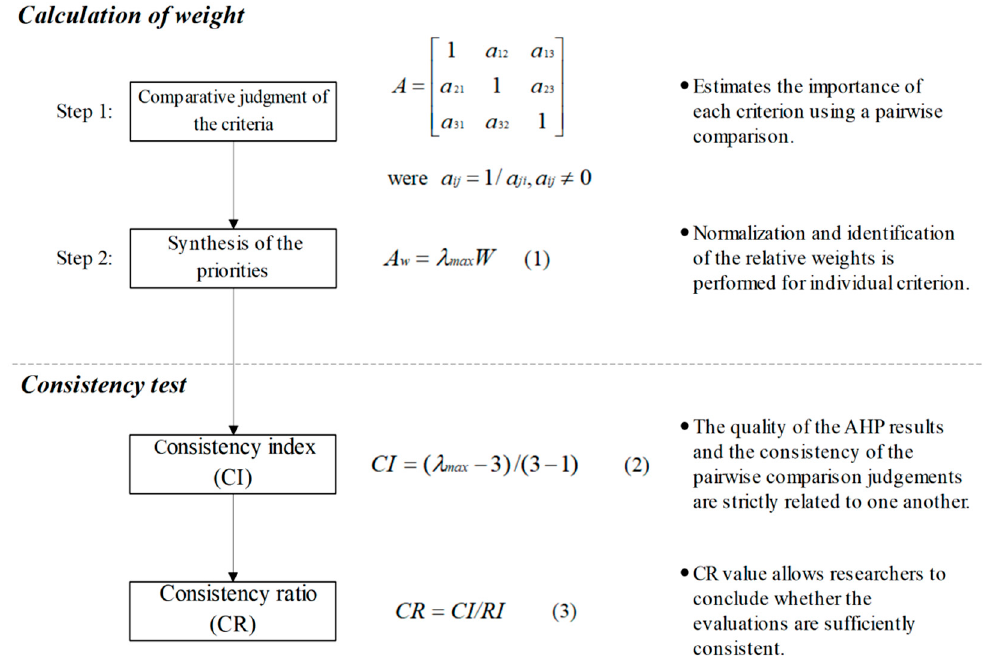
Figure 2. Execution steps of the Analytical Hierarchy Process (AHP) method (Note: The code (1), (2), (3) in this figure represent the formula number used in the AHP calculation process; RI in this figure represent Random Consistency Index).